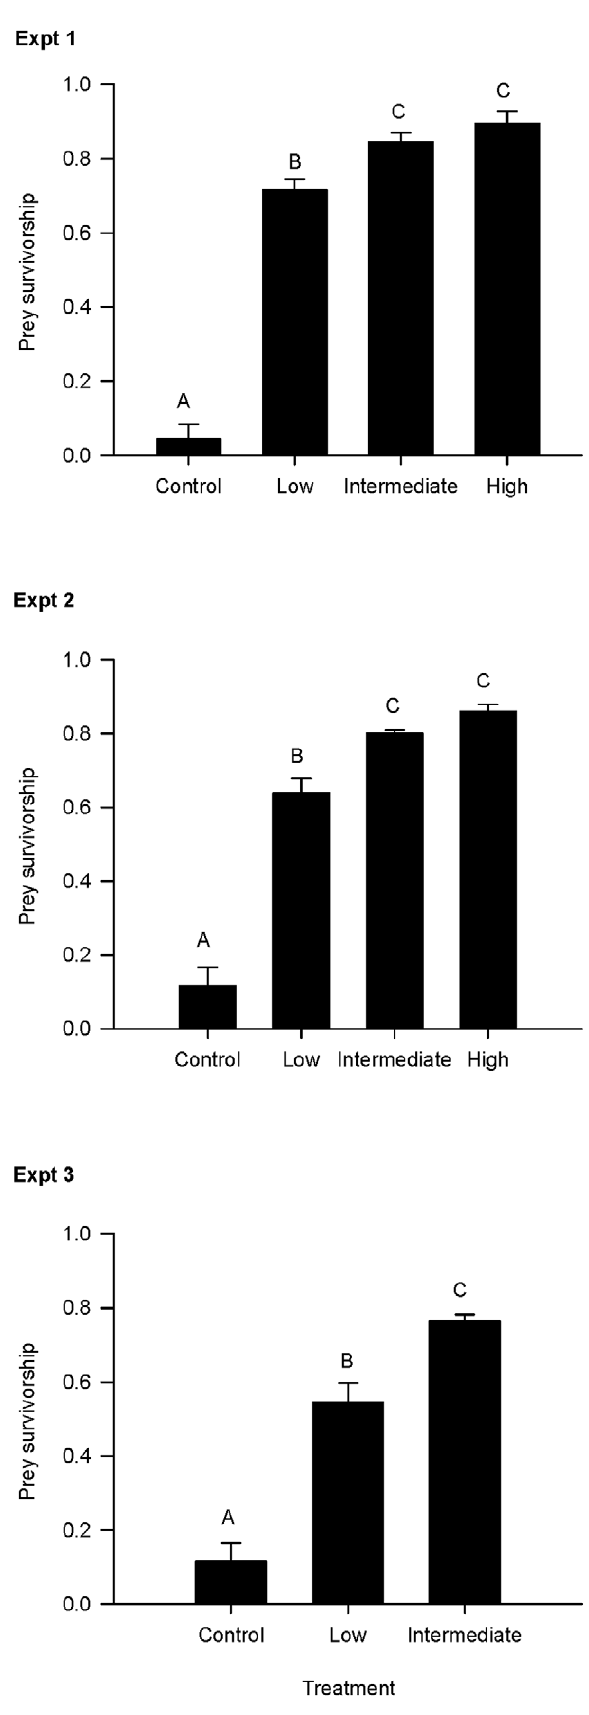
Figure 1. Prey survivorship (no. prey removed/no. prey initially stocked) by experiment. Vertical bars represent prey survivorship (mean 6 1 standard error), or the proportion of prey that survived in each treatment. Different letters represent significant (p , 0.05) differ- ences among treatments. Expt 1 used a fixed number of predator and prey individuals across treatments of variable levels of structural complexity. Expt 2 used the same structural treatments as the first experiment, but scaled the density of prey across treatments. Expt 3 used the same prey density treatments as the second experiment, but altered the amount of ‘predator-free space’ (by increasing interstitial space) in each structural treatment. Control treatments had no